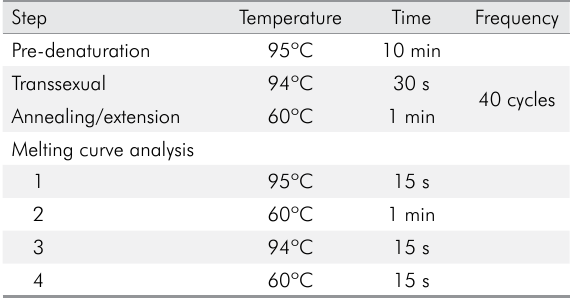
Table 2. PCR conditions.